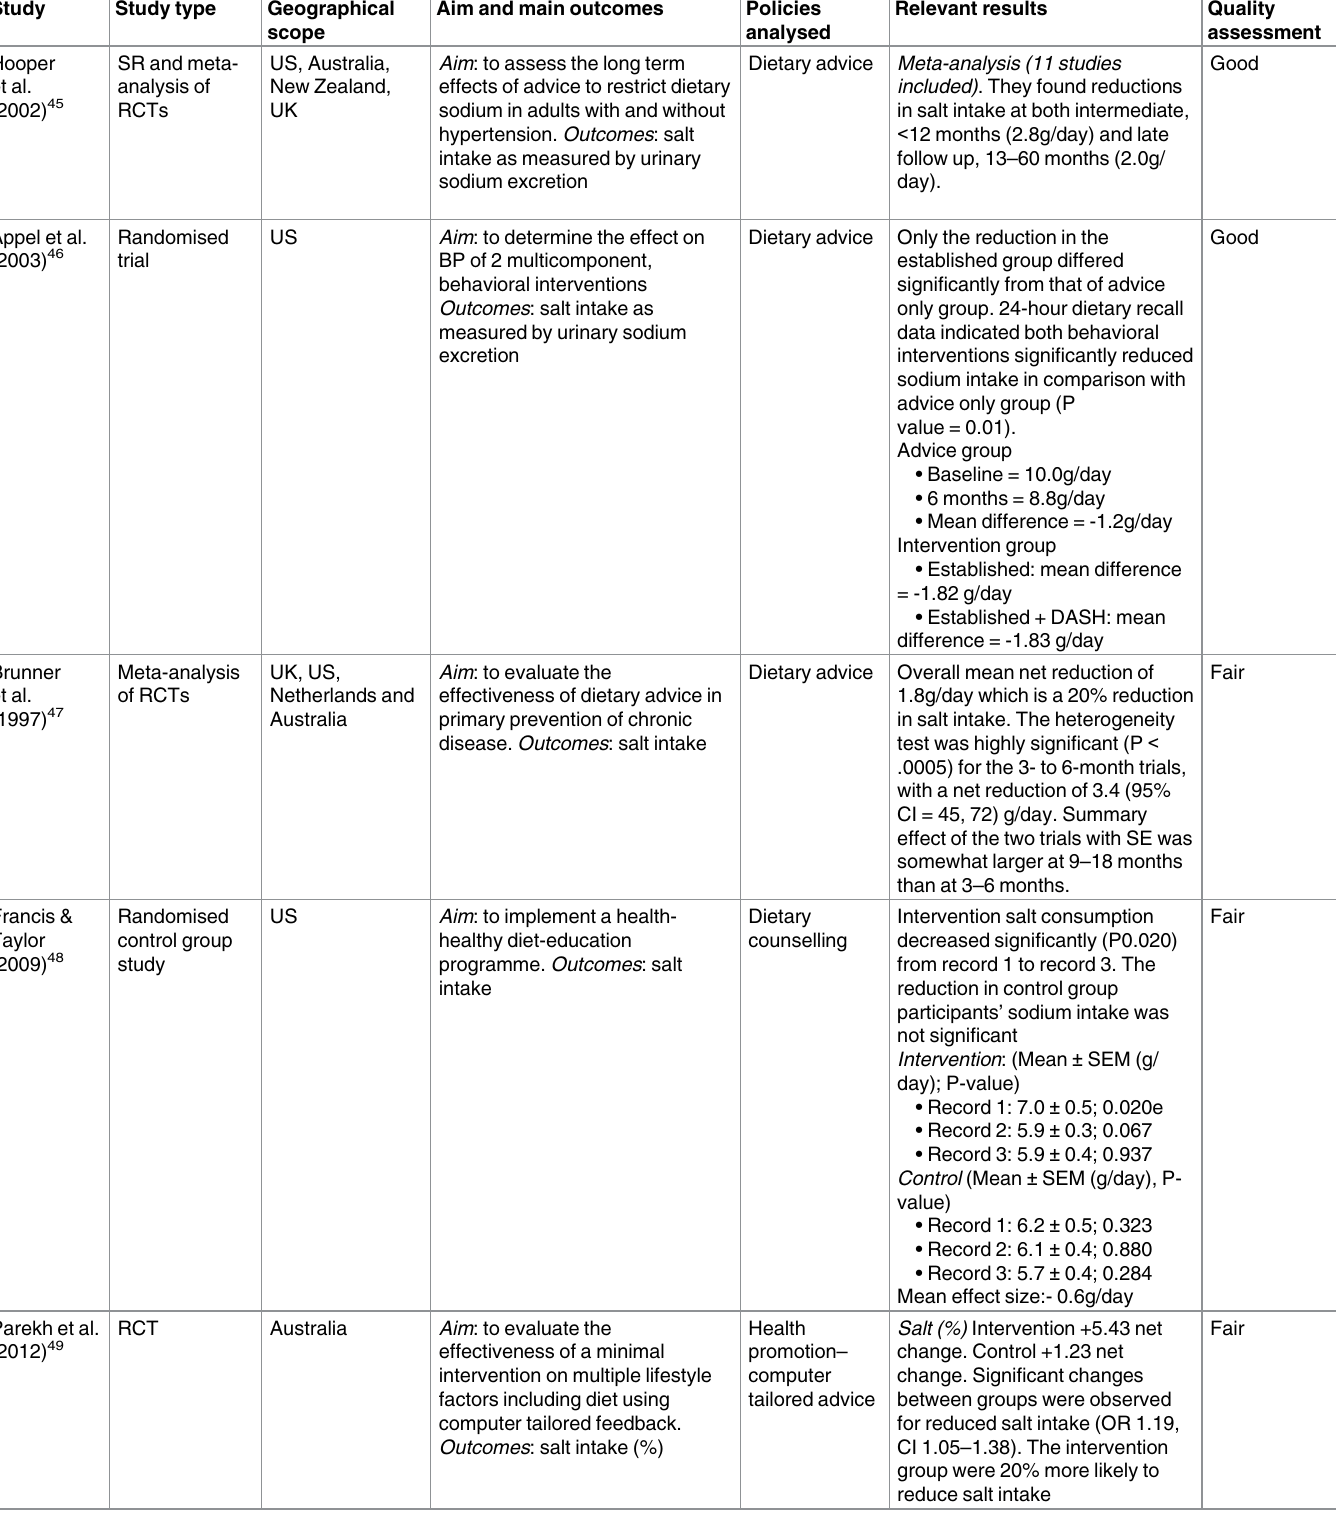
Table 2. Dietary counselling